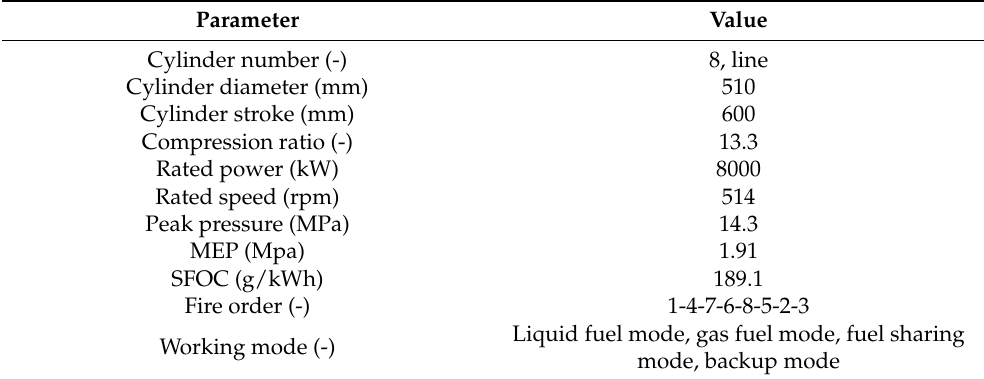
Table 1. Specifications of the dual-fuel engine under study (100% load). Parameter Value Cylinder number (-) 8,